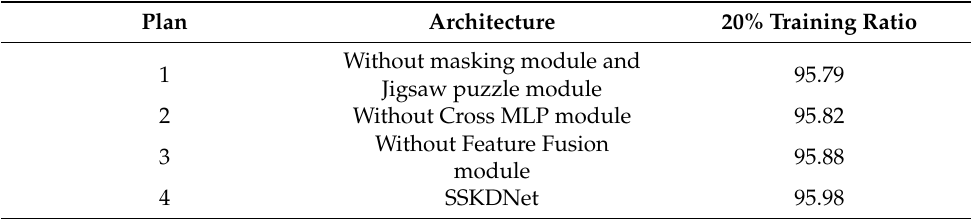
Table 6. Ablation experiments of modules on the AID dataset.